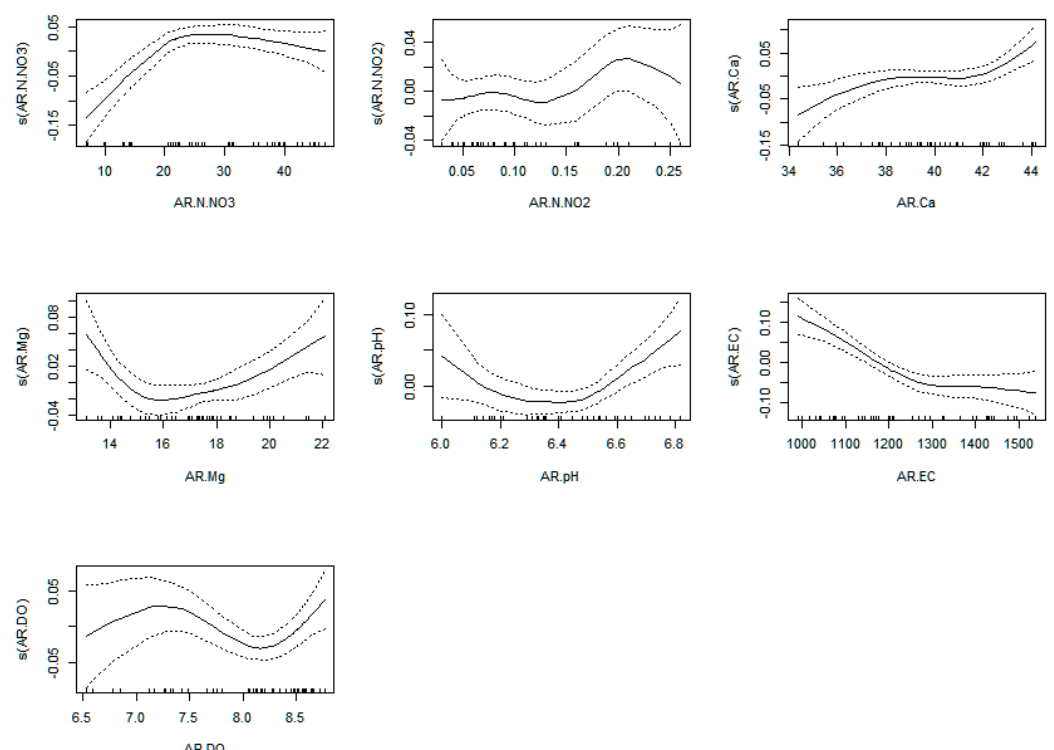
Figure A15. The GAM predictors influence over N-NH 4 for AR experimental variant.